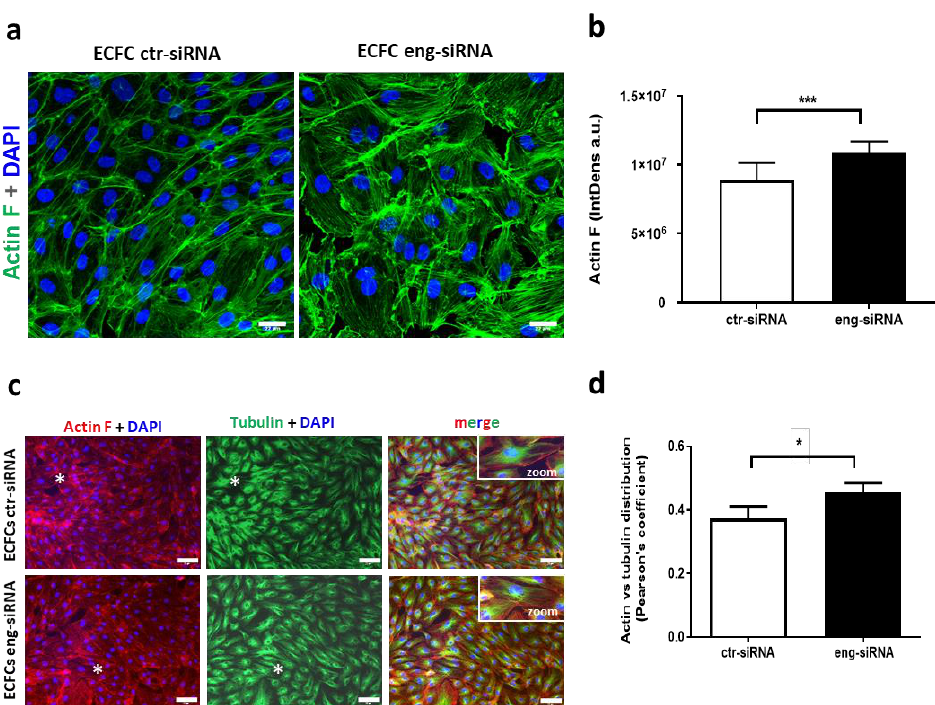
Figure 3. Endoglin silencing affects F-actin polymerization. ( a ) Immunofluorescence of F-actin (green, Phalloidin-Alexa 488) in ECFC ctr-siRNA and Eng-siRNA (scale bar, 22 µm). ( b ) Quantification of ( a ) (*** p < 0.001). ( c ) Co-staining of F-actin (red, Phalloidin-Alexa 546) and tubulin (green) (scale bar, 33 µm). ( d ) Evaluation of F-actin vs. tubulin distribution, using Pearson’s coefficient (* p < 0.05).